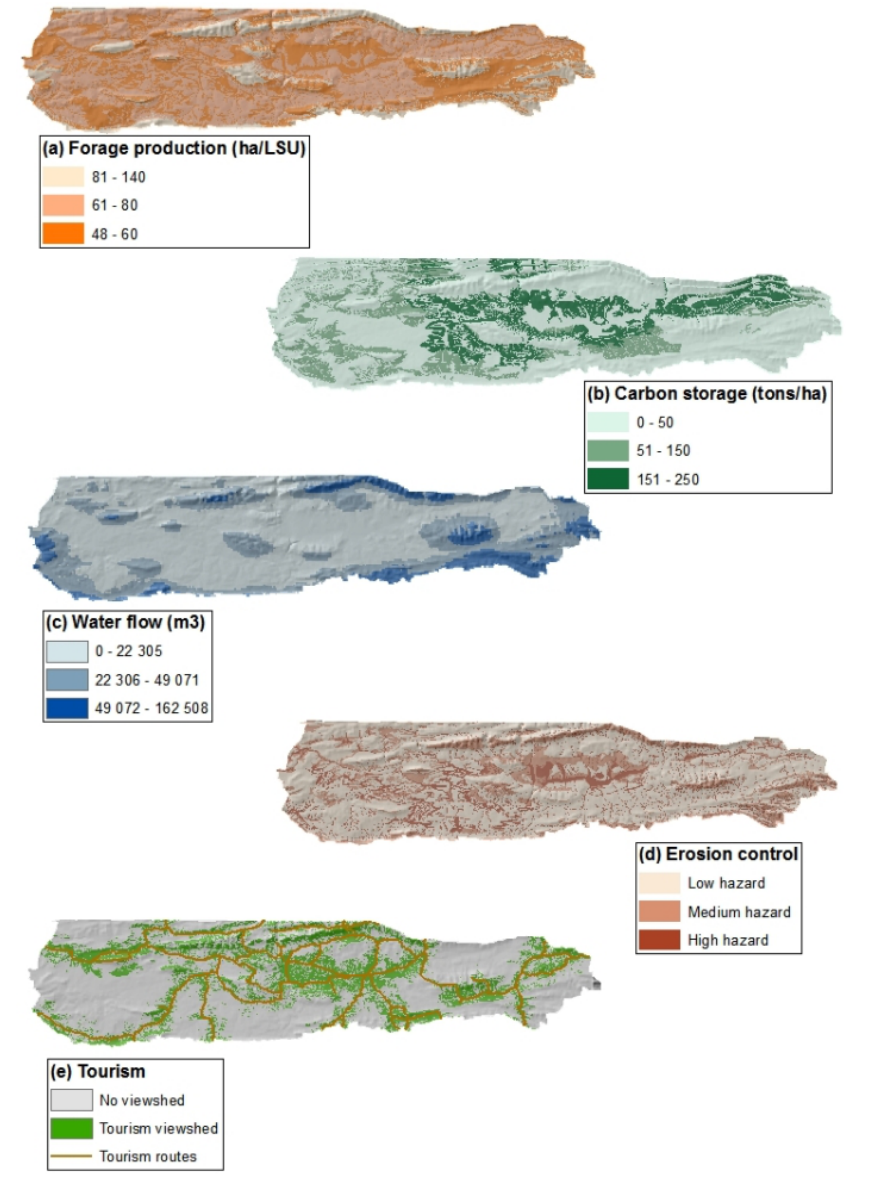
Figure 2. Maps of potential ecosystem services of the Little Karoo illustrating: (a) Forage production: number of hectares required by a large stock unit (LSU) in each habitat type; (b) Carbon storage: tons of carbon stored per hectare of each habitat type; (c) Water-flow regulation: volume of water provided by a 1-km 2 grid; (d) Erosion control: areas of high, medium, and low erosion hazard requiring the maintenance of natural vegetation cover; and (e) Tourism: 10-km viewshed seen by tourists from the major tourist